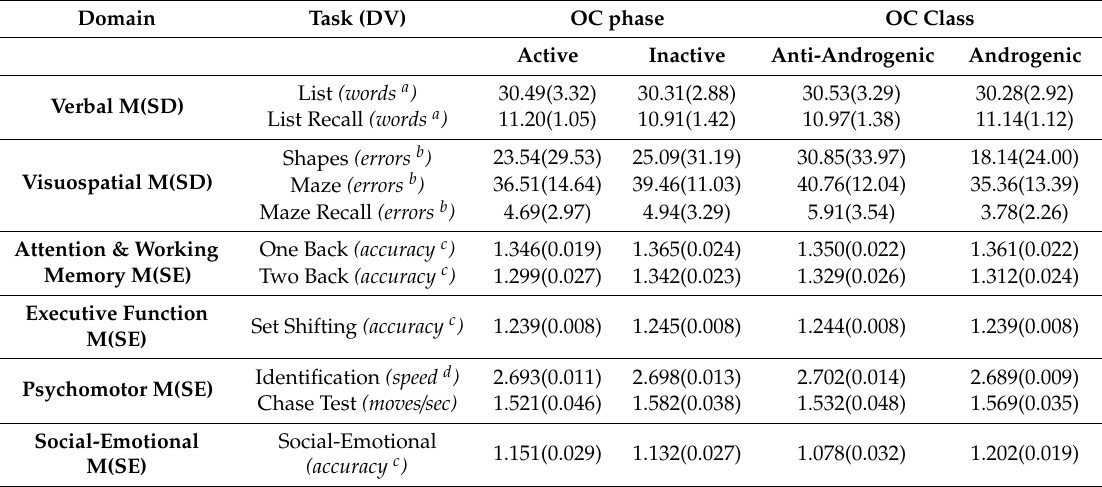
Table 4. Mean (SD or SE) for each cognitive task by pill phase and pill class.